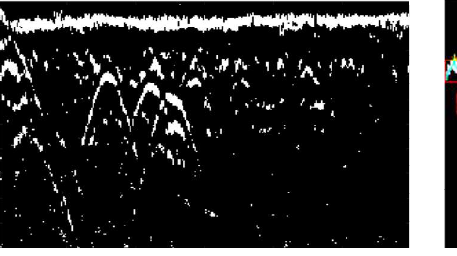
Figure 9 . Result of a B-Scan with adaptive Figure 10 . Two results of consecutive B-Scans. Regions with bounding box (red), threshold. skeleton line (cyan) and estimated maximum of hyperbola